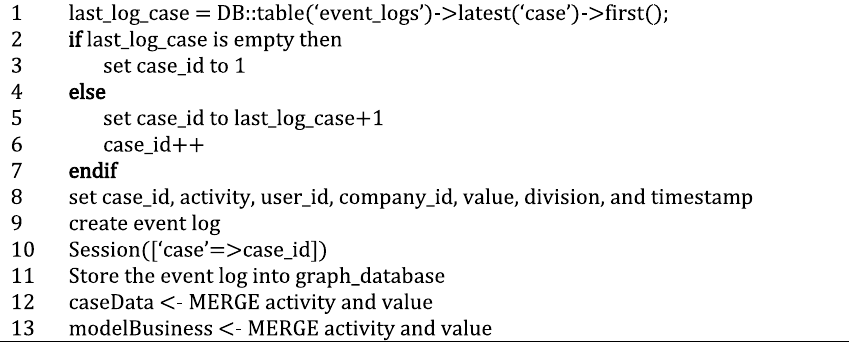
Table 3 The algorithm of logging